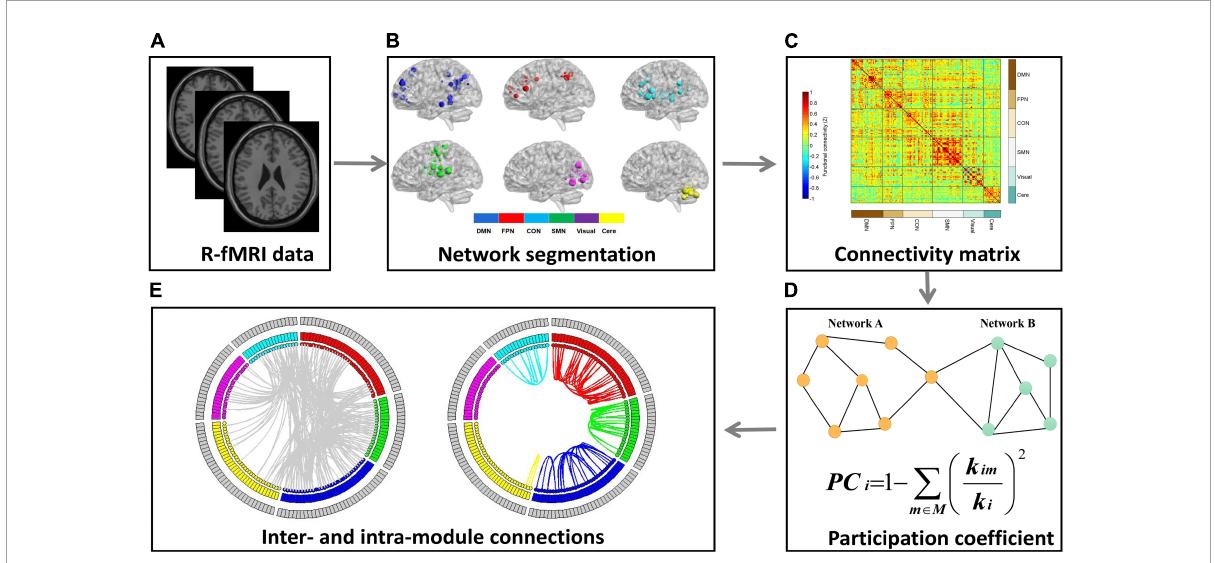
FIGURE1 The schematic illustration of processing steps. This figure showed the data analysis pipeline of the present study. (A) Resting-state fMRI (R-fMRI) images were acquired from all subjects. (B) The Dosenbach 160 regions were used as network nodes of the whole brain and the 160 nodes were parcellated into six functional modules. (C) We conducted Pearson’s correlation analysis between each pair of nodes to construct a 160 × 160 correlation matrix for each participant. (D) The mean participation coefficient (PC) for each module was calculated to quantify the modular segregation. (E) The number of intra- and inter-module connections were calculated to explore the reasons for PC abnormalities among the two